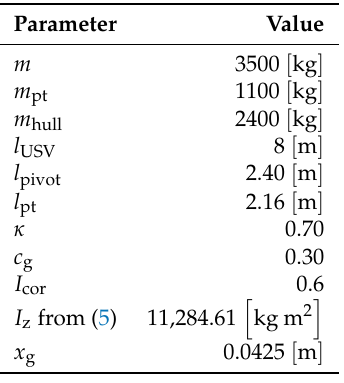
Table 3. Principal characteristics of the under-actuated USV.